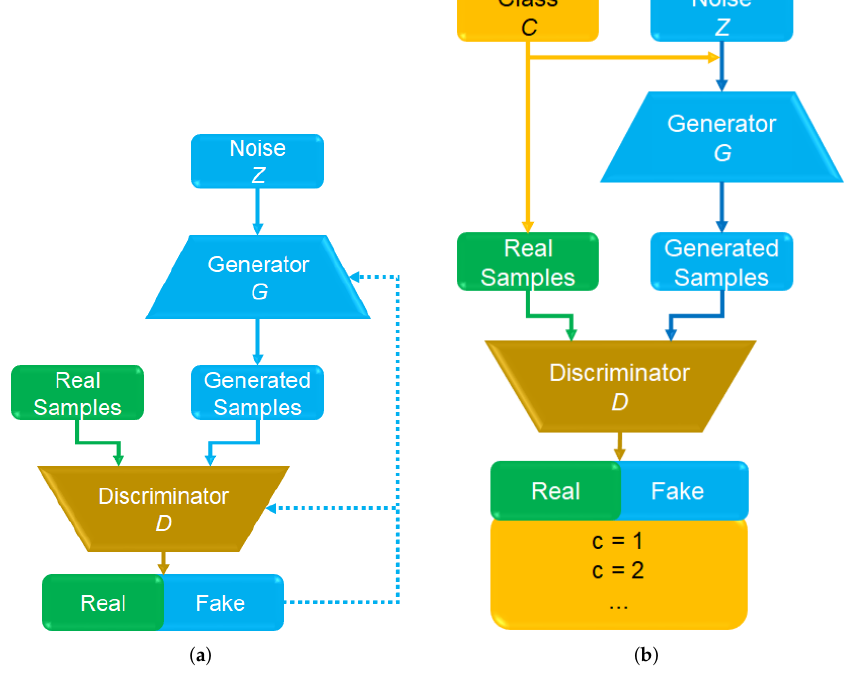
Figure 2. ( a ) Basic structures of the GAN model; and ( b ) the GAN with auxiliary